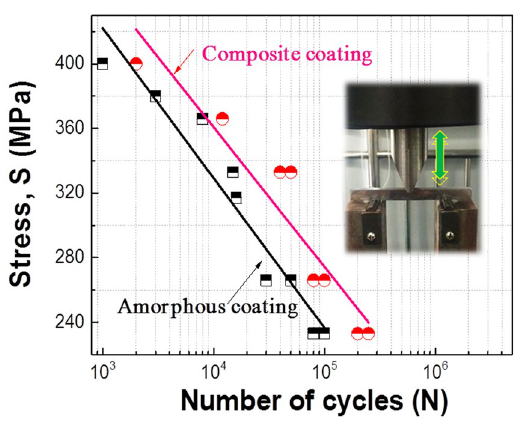
Figure 6. S-N curves for the amorphous coating and the composite coating. Inset shows a picture for fatigue experimental